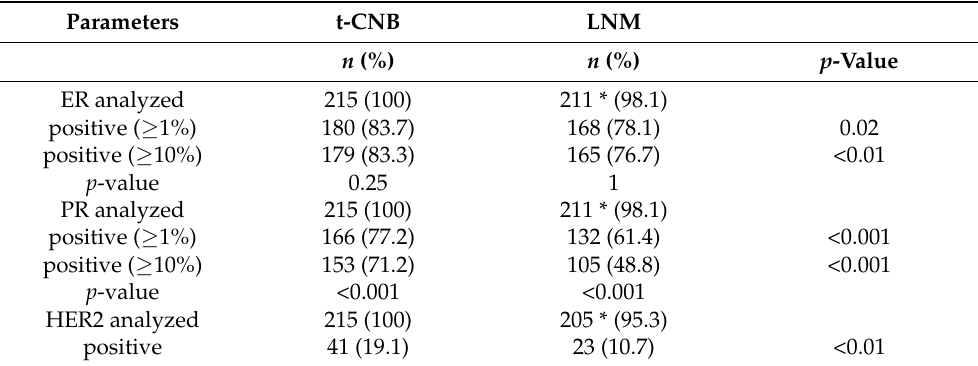
Table 2. Receptor analysis of ER, PR and